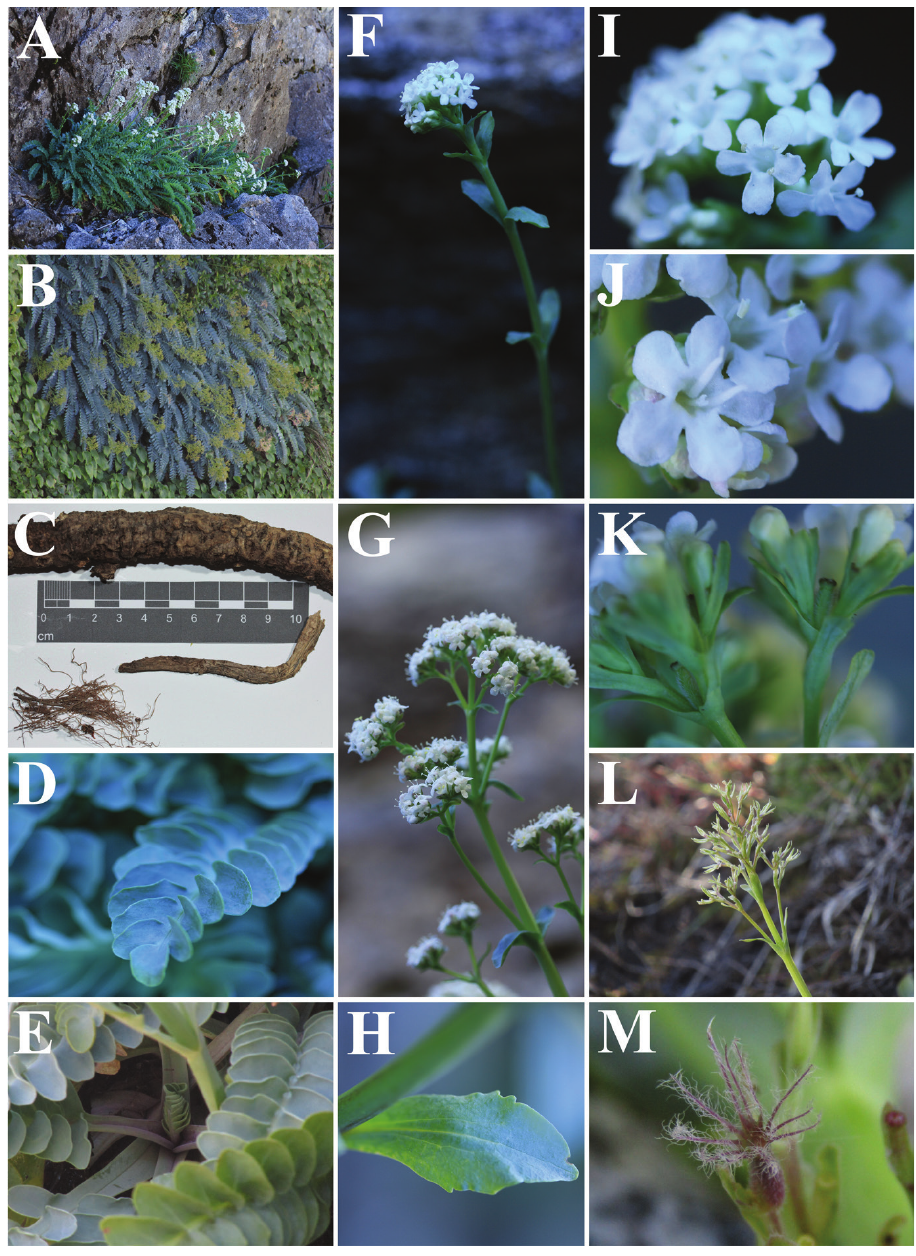
Figure 4. Valeriana praecipitis A, B plants growing in natural habitat C rhizome, secondary-tertiary roots D basal leaves with lobes detail E petioles F floral stem, corymboid inflorescence G floral stem, thyrse inflorescence H upper leaves I, J detail of flowers (stamens, style) K bracteoles, ovary, calyx L dry inflo- rescence, bracts, bracteoles M fruit, pappus. Photographed by Alejandro E. Villarroel and Kora